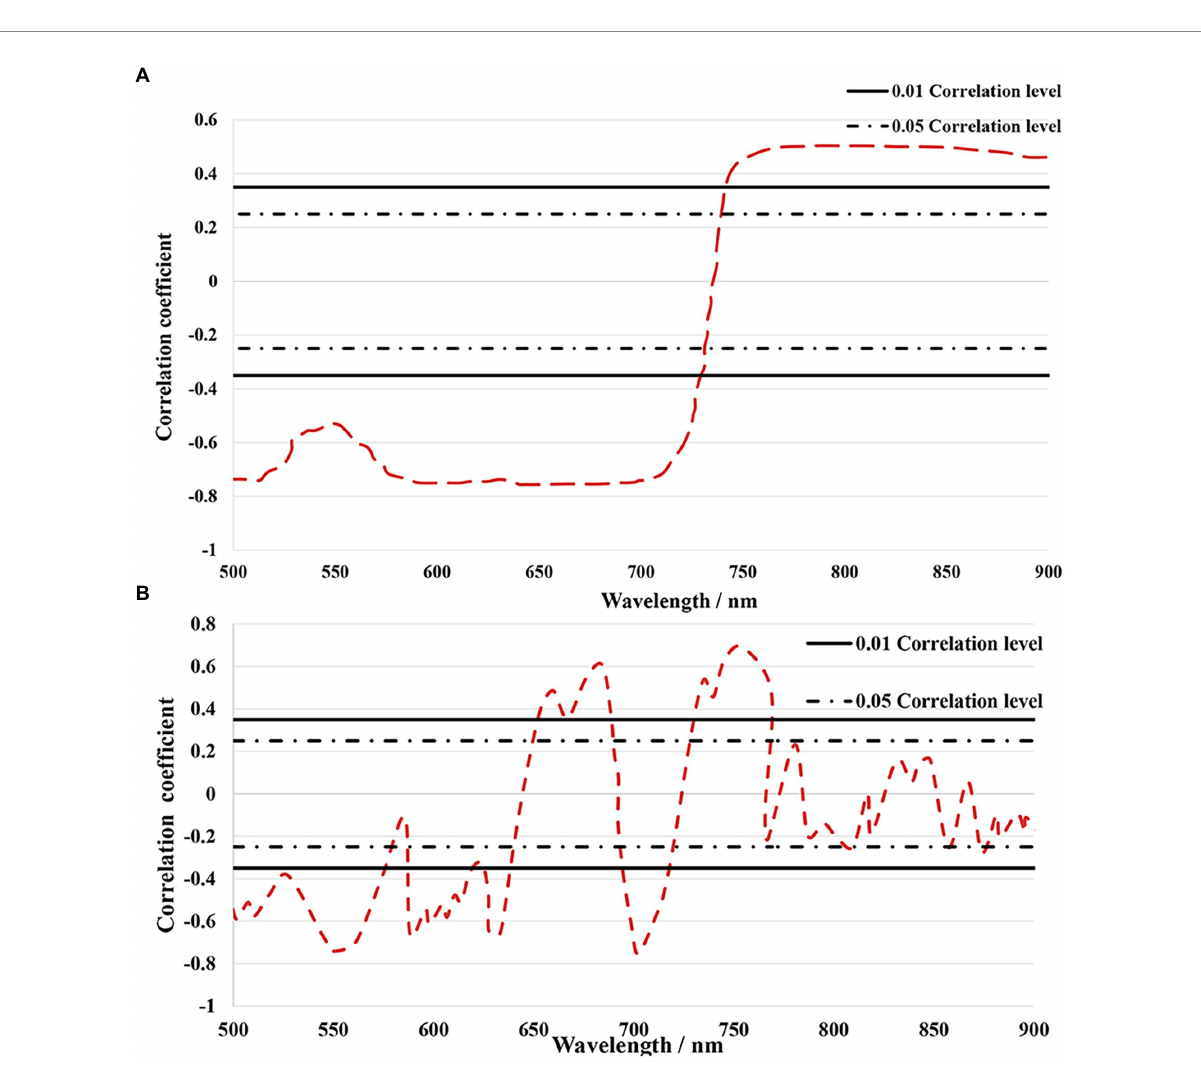
FIGURE 6 (A) Raw spectra with SPAD correlation analysis; (B) First-order derivative spectra with SPAD correlation